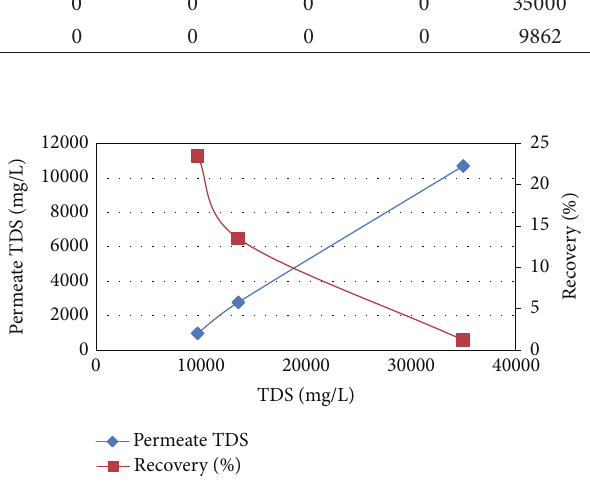
Figure 8: Effect of salinity on water recovery and permeate TDS for RO process at 15 bar with synthetic SW and diluted DS from FO process by Ezz Steel treated